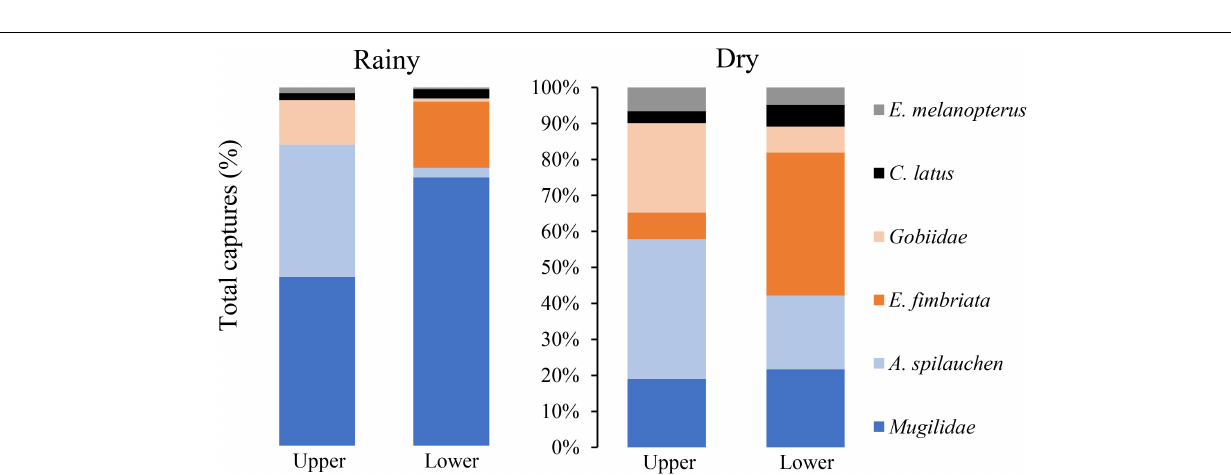
Frontiers in Marine Science |